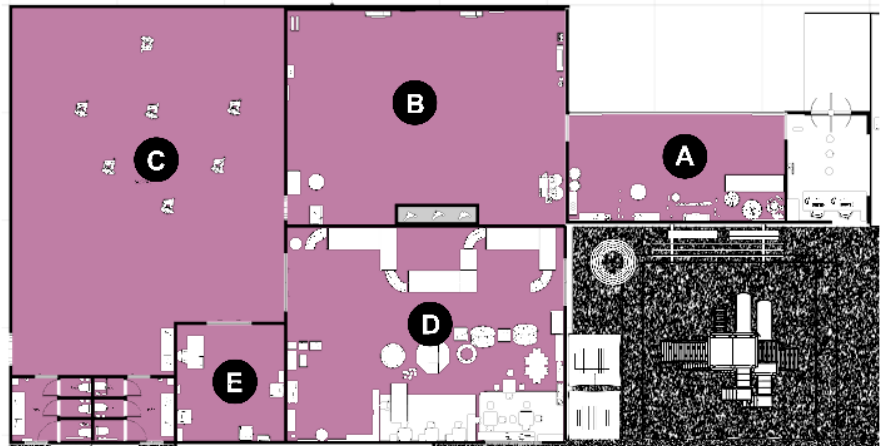
Figure 5. Aerial view of the layout of the Cultural Interpretive Center.